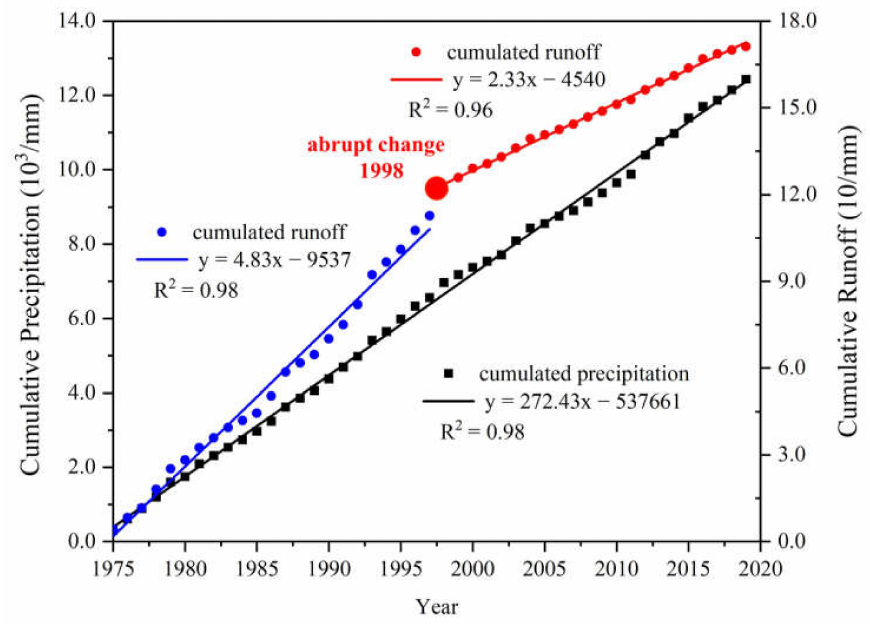
Figure 4. Double mass curve of the cumulative precipitation and runoff